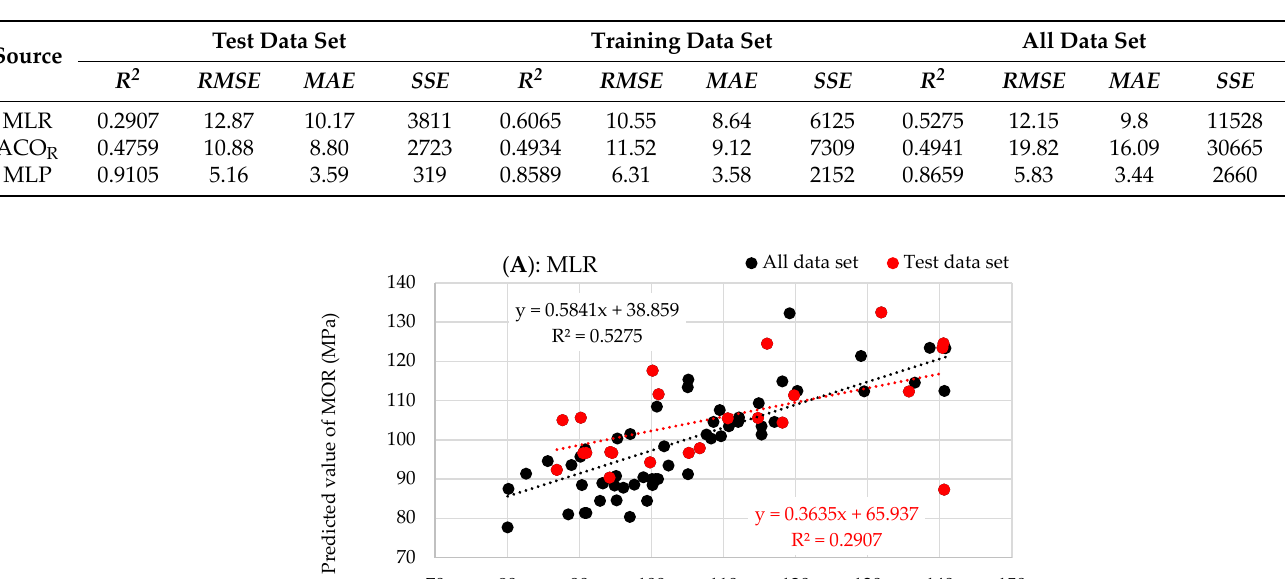
Table 4. The statistics resulting from the testing, training and all data sets based on the MLR, ACO R and MLP approaches.